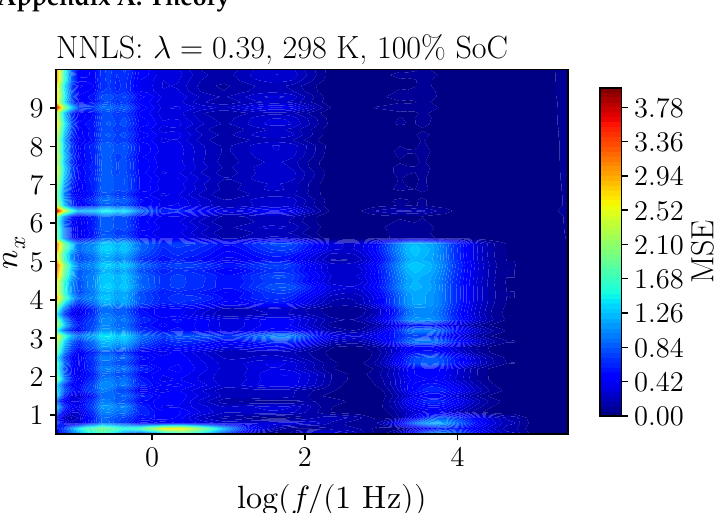
Figure A1. Influence of the number of sample points as mean squared error (MSE) between measure- ment and reconstruction for EIS measurement of a ZAB at 298 K and SoC of 100%. The numbers n correspond to multiples of the number of frequency points m